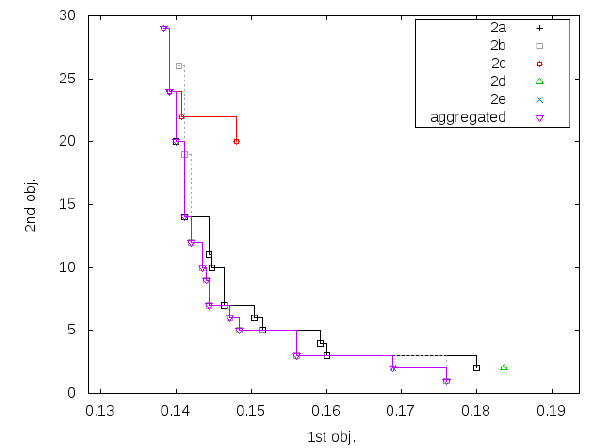
Fig. 8. The Pareto front approximations obtained for wave- form using the five fitness functions. Objective 1 stands for test error and objective 2 for complexity. The pseudo- optimal Pareto front is also drawn for